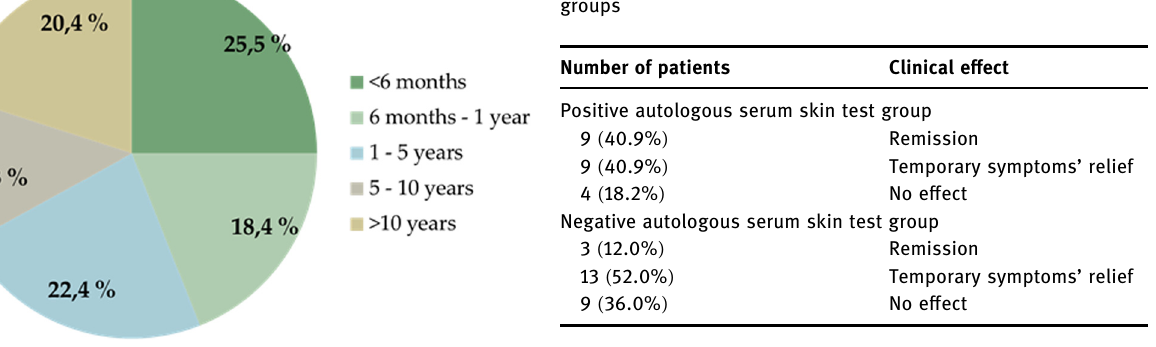
Table 3: Plasmapheresis e ff ect in positive and negative ASST